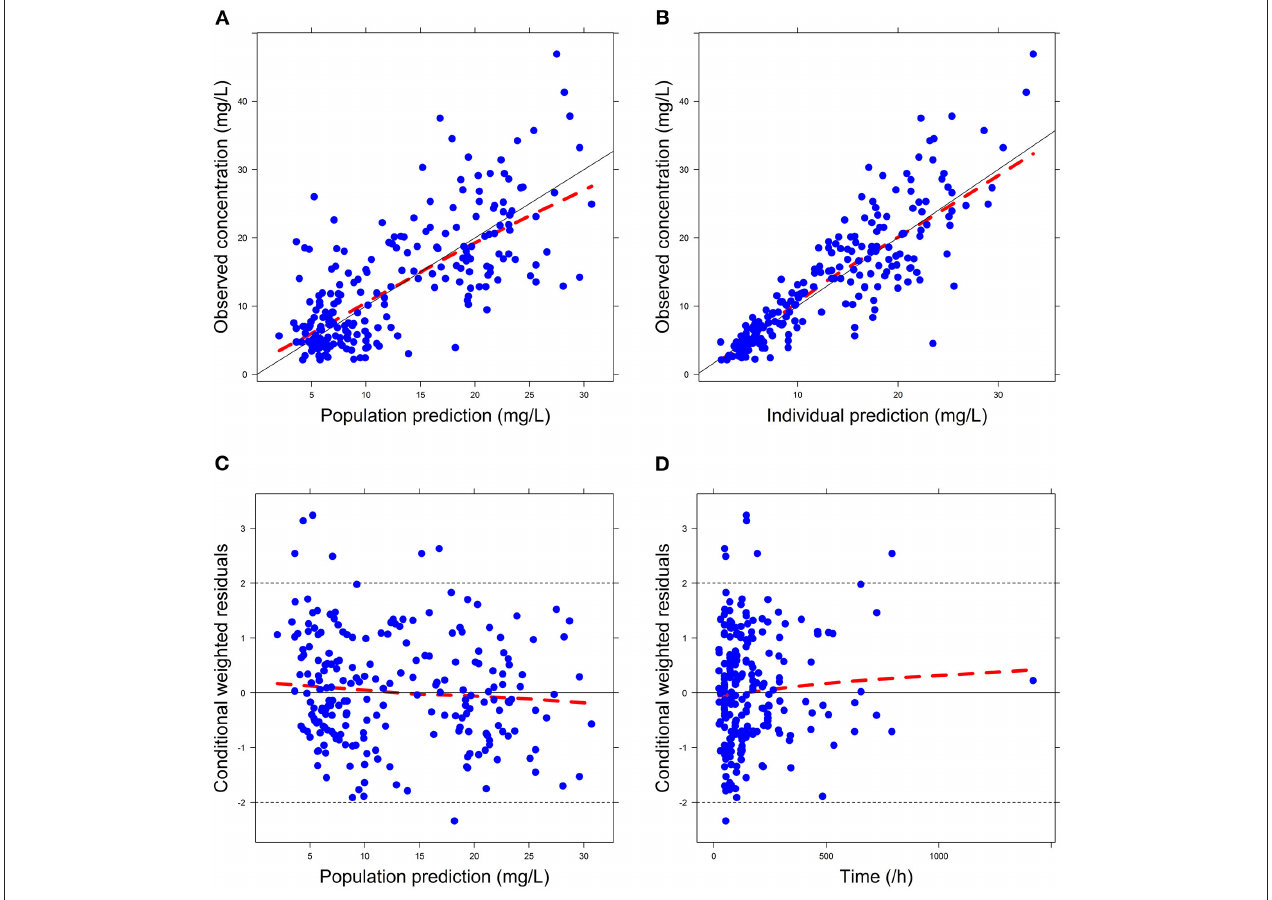
FIGURE 3 | Goodness-of-fit (GOF) plots of Model 3: (A) observed concentration (DV) vs. population prediction (PRED); (B) DV vs. individual prediction (IPRED); (C) conditional weighted residual errors (CWRES) vs. PRED; (D) CWRES vs.